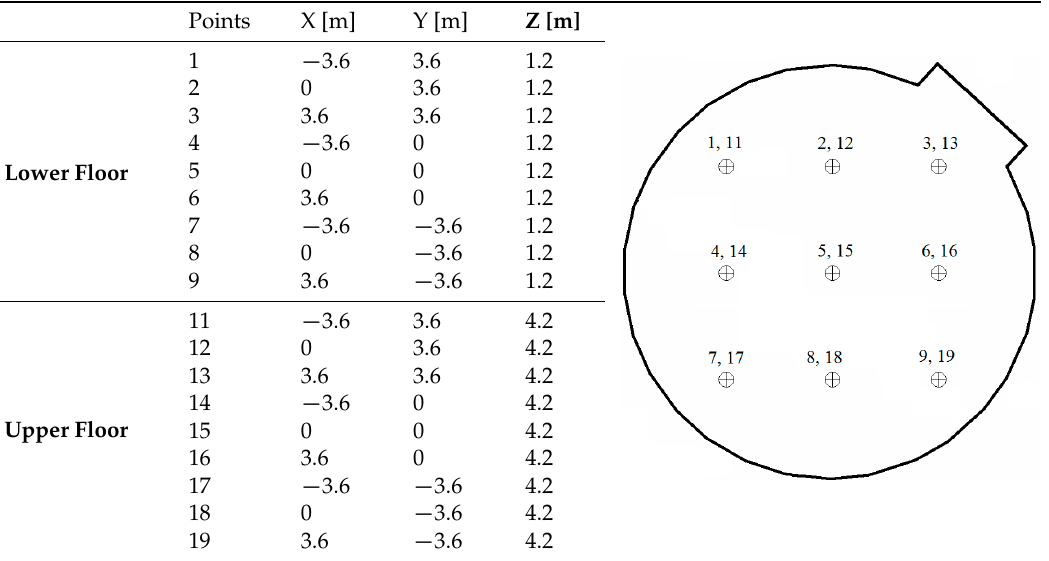
Table 3. Location of measurement points in lower (1–9) and upper floors (11–19).